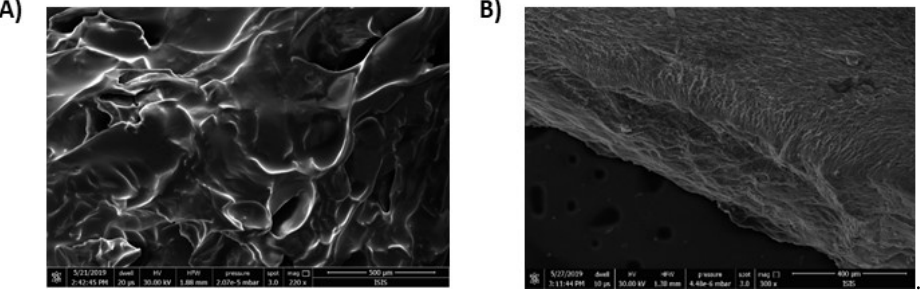
Figure 5. SEM images of HGel-B ( A , scale bar 500 µ M) and HGel-C ( B , scale bar 400 µ M).